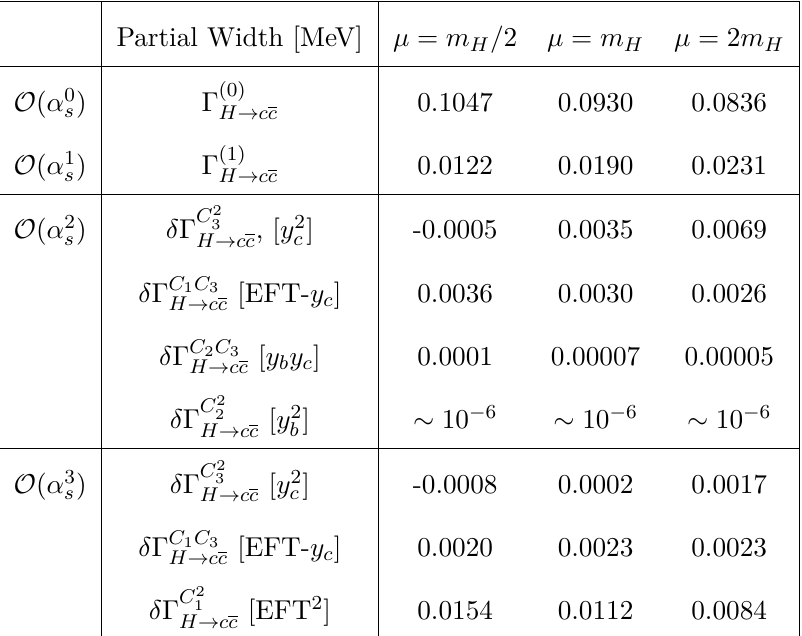
Table 2. Inclusive partial width results for H → cc at LO, and higher order coefficients for NLO y 2 contributions, and the top induced pieces at O ( α 2 c